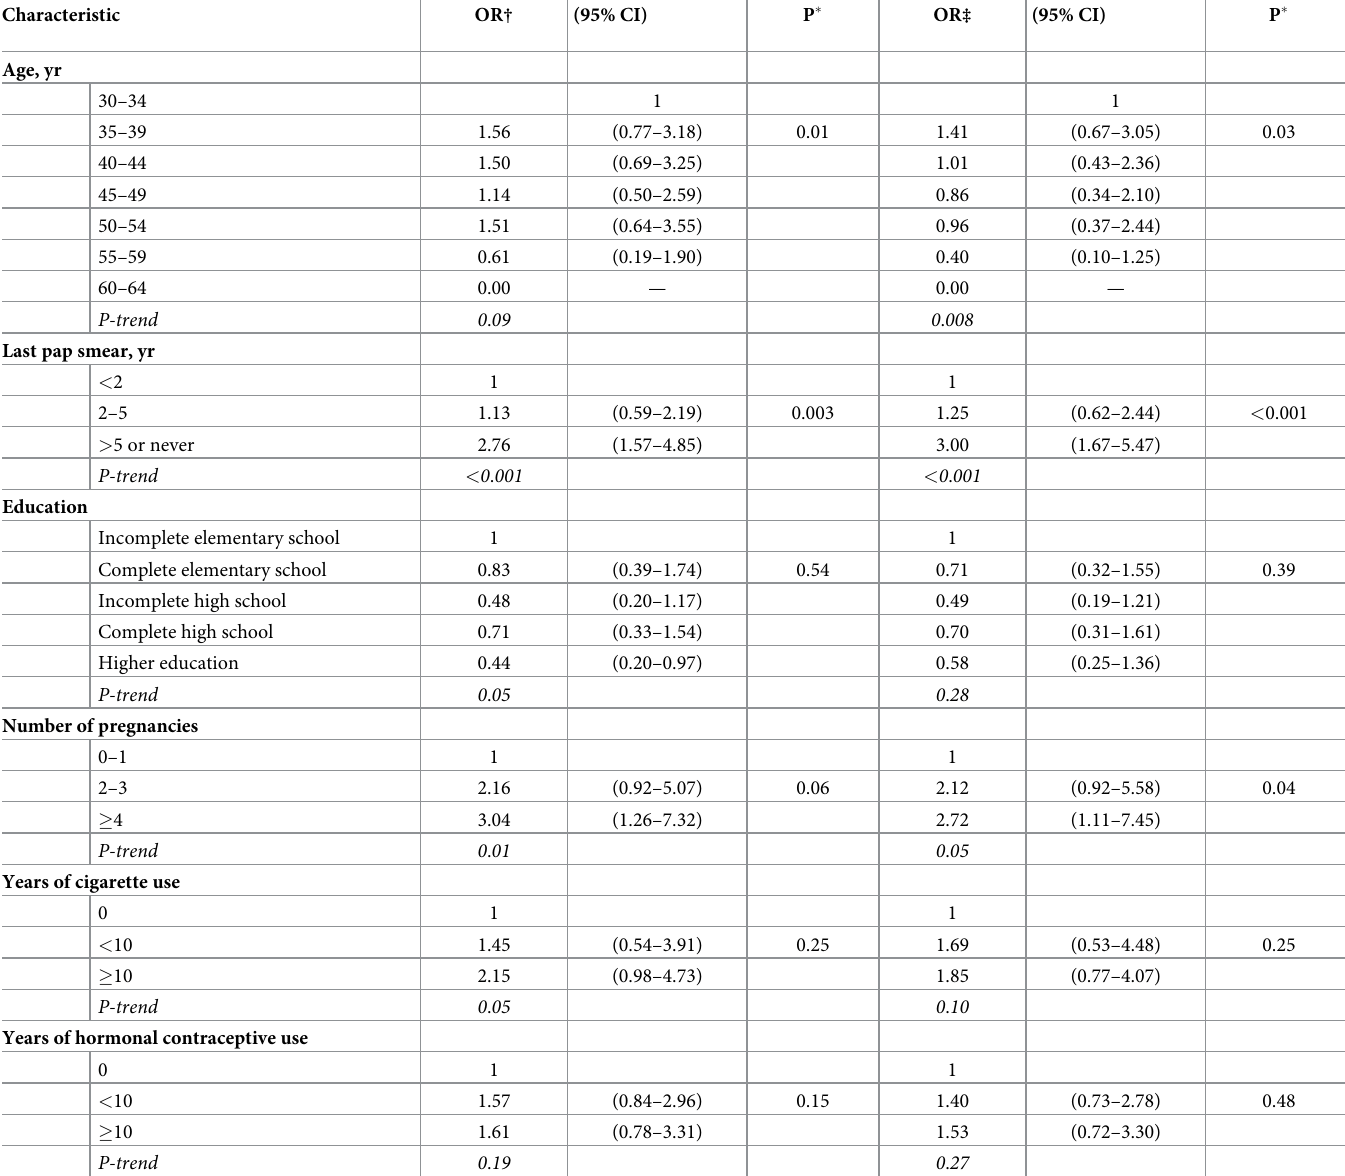
Table 5. Odds ratios of CIN2+ associated with sociodemographic characteristics and selected risk factors among 30-69-year-old hrHPV+ women from the Central Department, Paraguay.